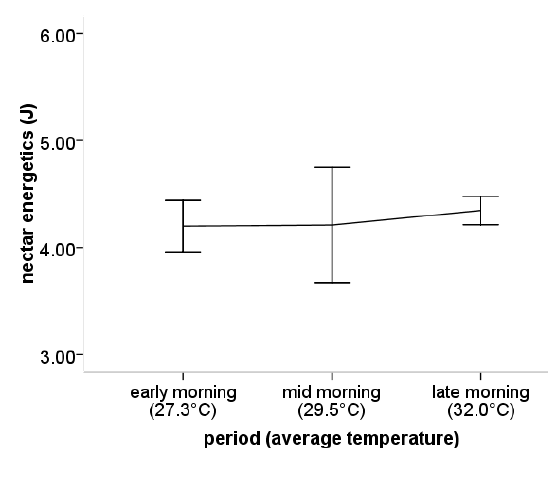
F IG . I. Nectar energetic per 1µL of nectar of A. comosus at different times of the day with average temperatures. Error bars represent 2 SE.